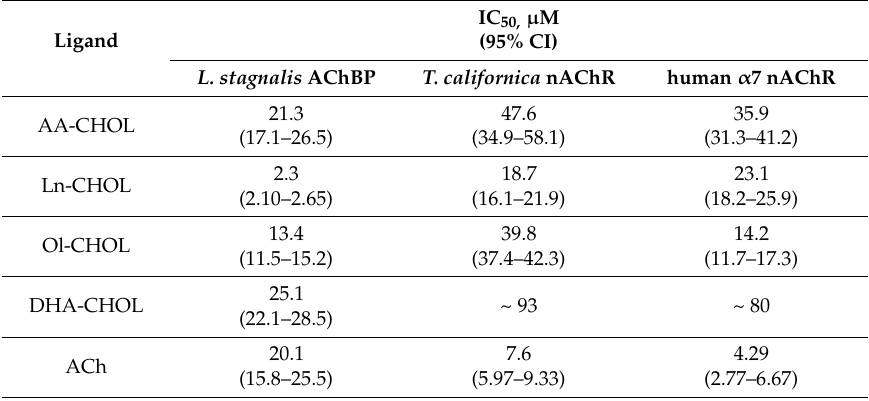
ACh, and Ol-CHOL vs. DHA-CHOL were significant with p < 0.05.